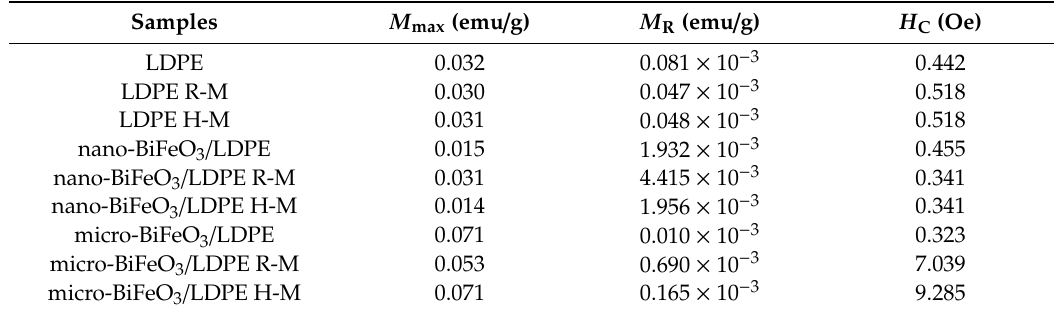
Table 2. Magnetic parameters of neat LDPE and BiFeO 3 / LDPE